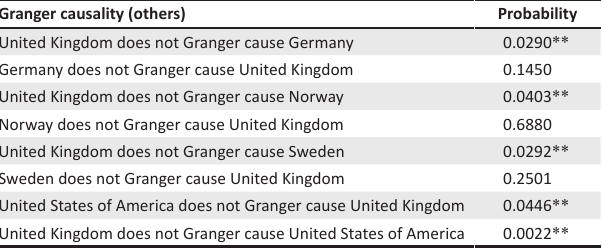
TABLE 5: Granger causality test (others). Granger causality